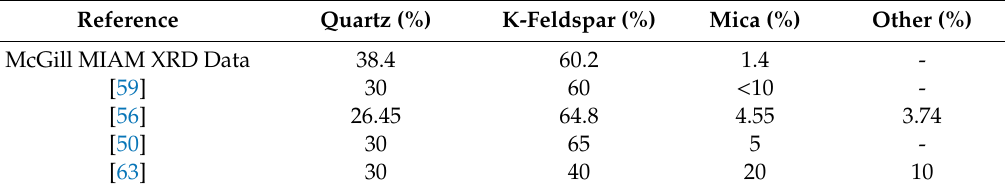
Table 2. Mineralogical composition of the Lac du Bonnet granite.